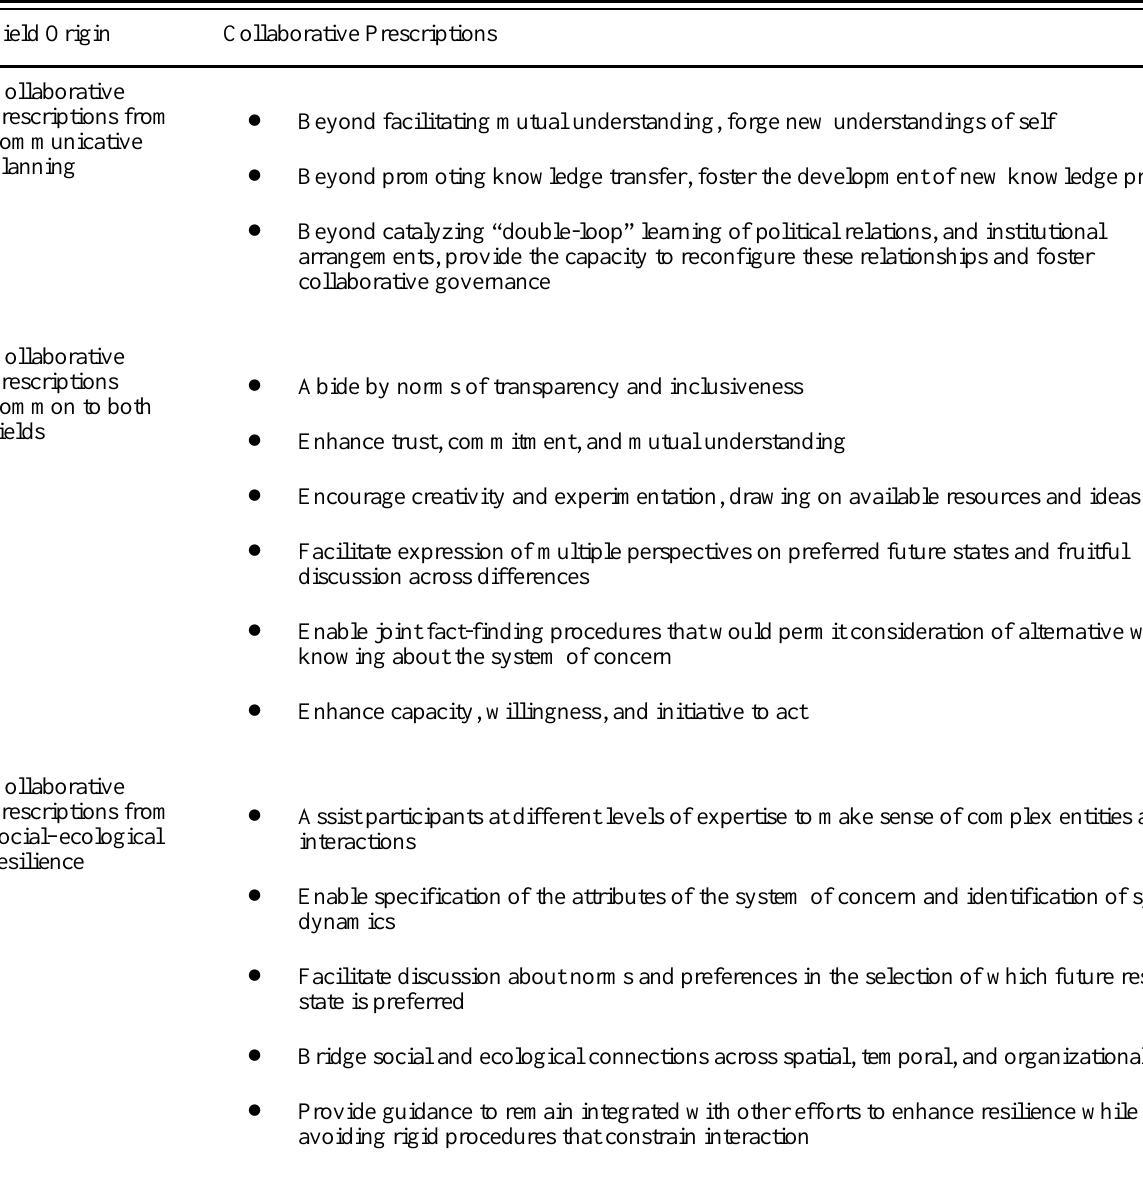
Table 2. Shared and unique collaborative